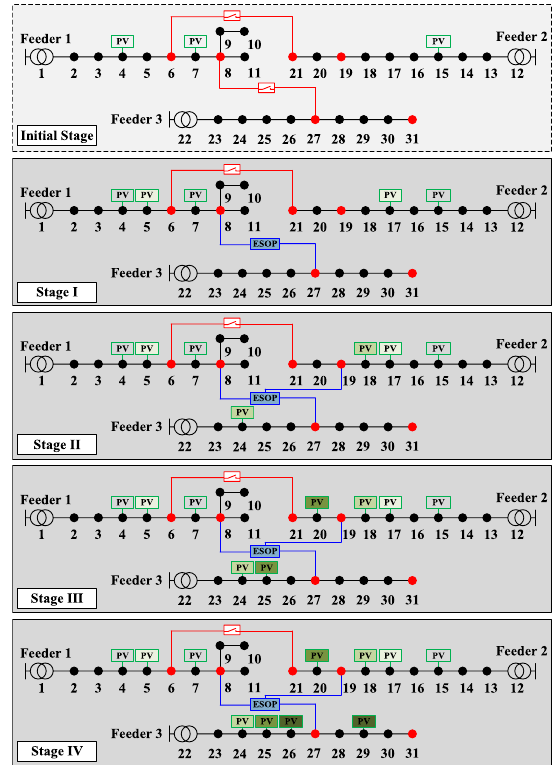
Fig. 5 Planning results of the network based on ESOP in Case I